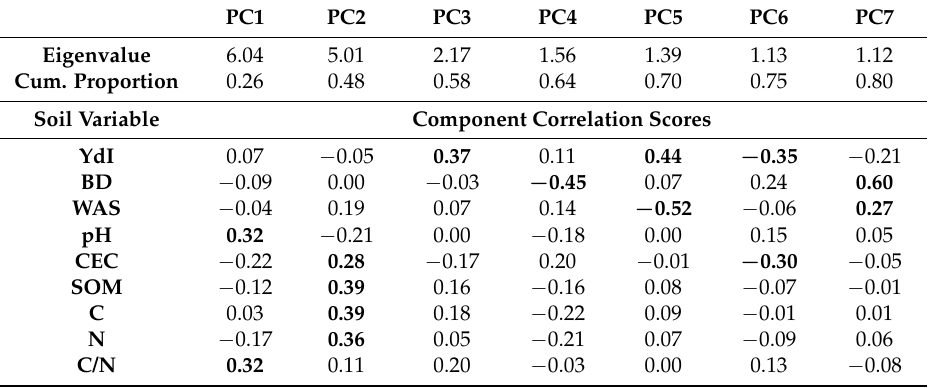
Table 2. Principal component analysis based on 52 observations modeling GHG emissions (N 2 O, CO 2 , and CH 4 ) with 23 variables, with eigenvalues and the cumulative proportion of the dataset variability explained by the seven principal components (PC) extracted with eigenvalues >1. Component correlation scores (eigenvalues) with loadings greater than |0.25| are in